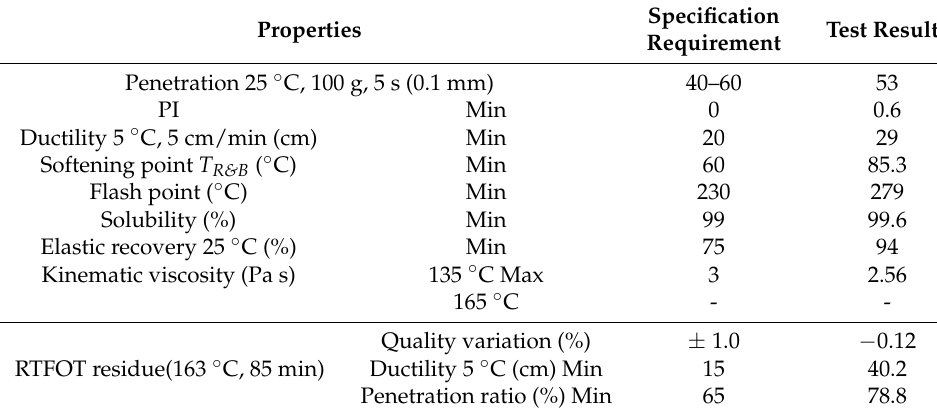
Table 1. Technological parameters of the SBS-modified